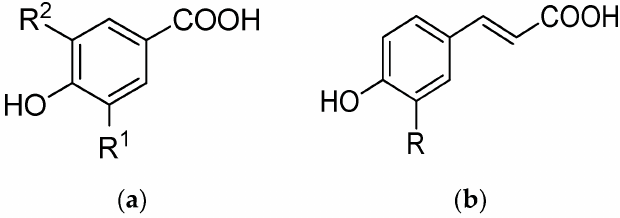
Figure 1. Chemical structure of ( a ) hydroxybenzoic acids (vanillic acid: R 1 = OCH 3 , R 2 = H; syringic acid: R 1 = R 2 = OCH 3 ; gallic acid: R 1 = R 2 = OH); ( b ) hydroxycinnamic acids (caffeic acid: R = OH; ferulic acid: R = OCH 3 ; p-coumaric acid: R = H) [52].